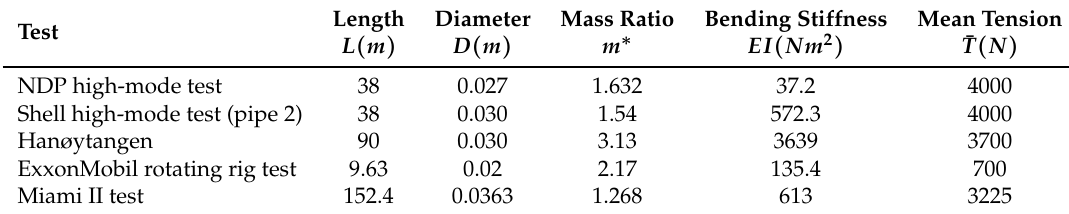
Table 1. Summary of physical properties of the riser/pipe model of various elastic model vortex-induced vibration (VIV)